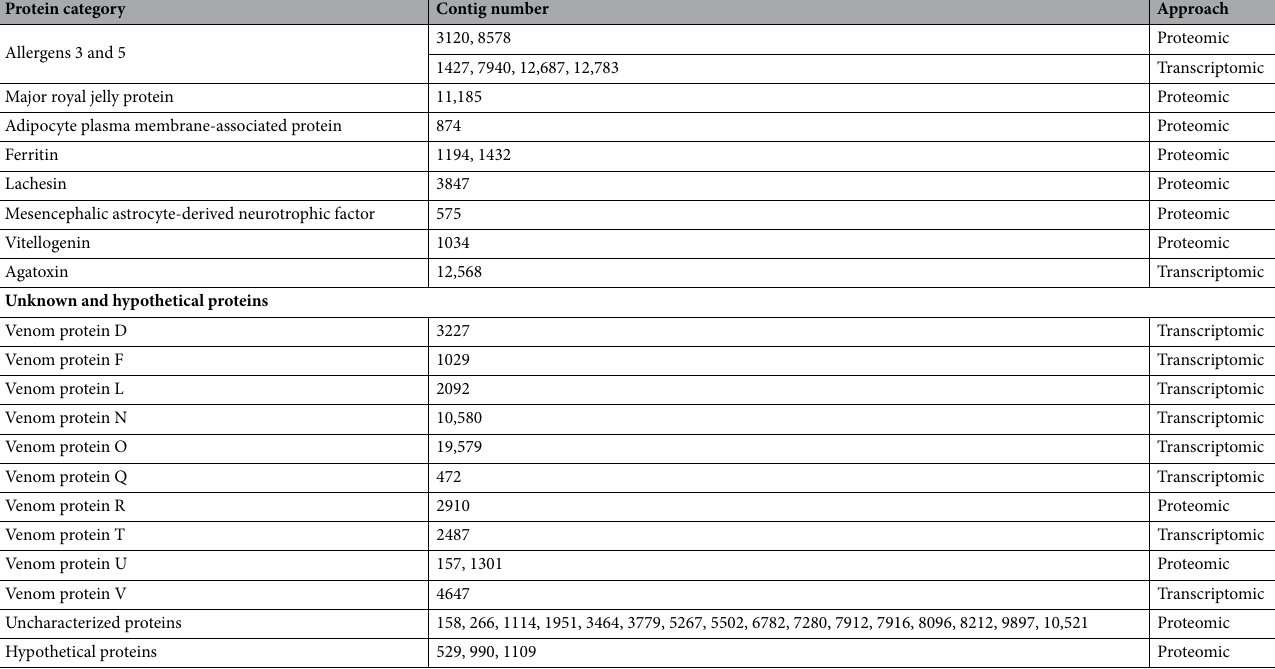
Table 2. T. sinensis venom proteins, identified by the transcriptomic or proteomic approach, categorized according to their role. The table contains the contig number and the approach by which each protein was